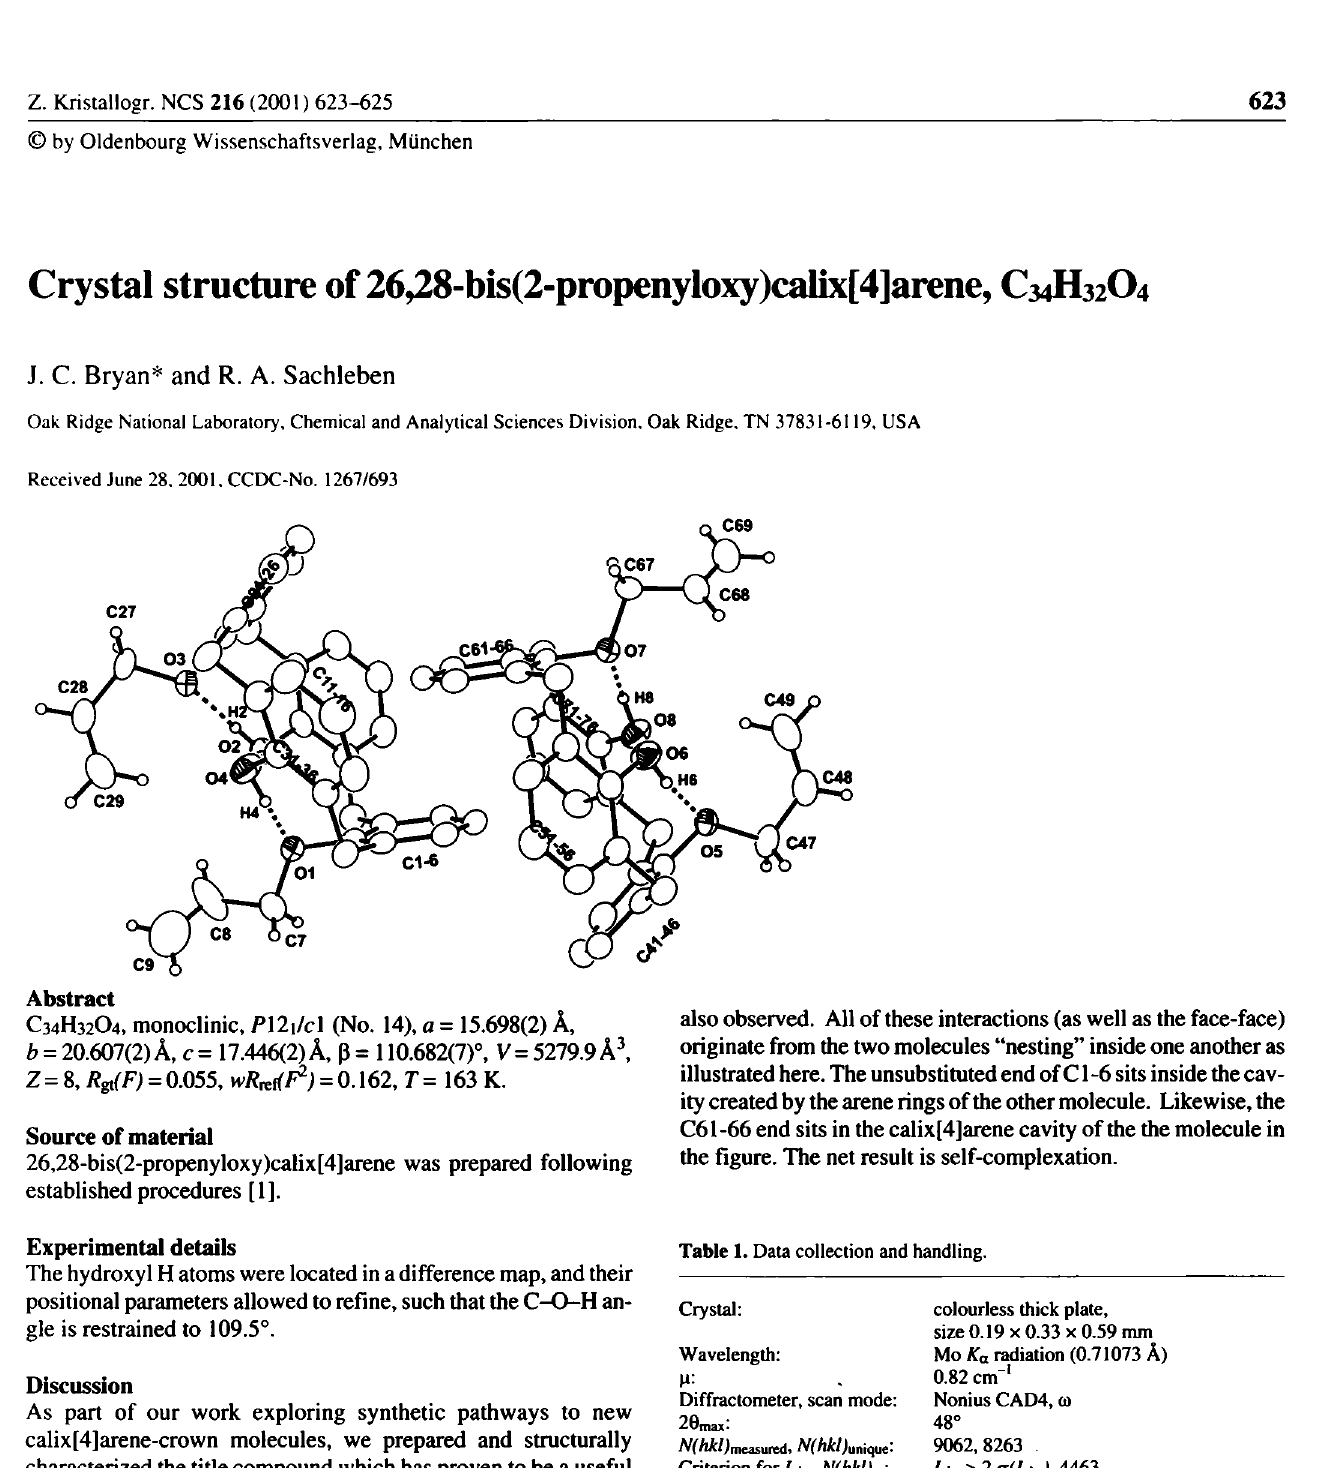
Table 1. Data collection and handling.